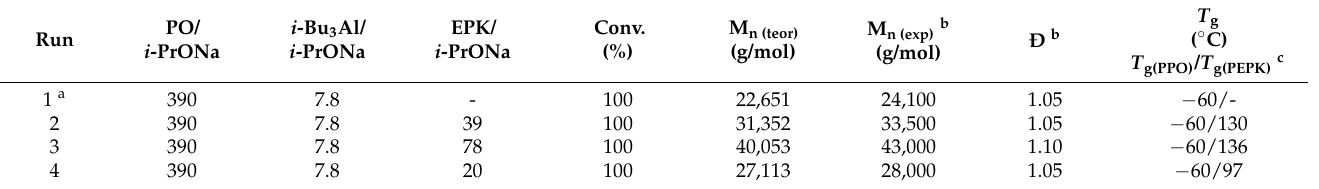
Table 1. Experimental polymerization conditions and copolymer features.